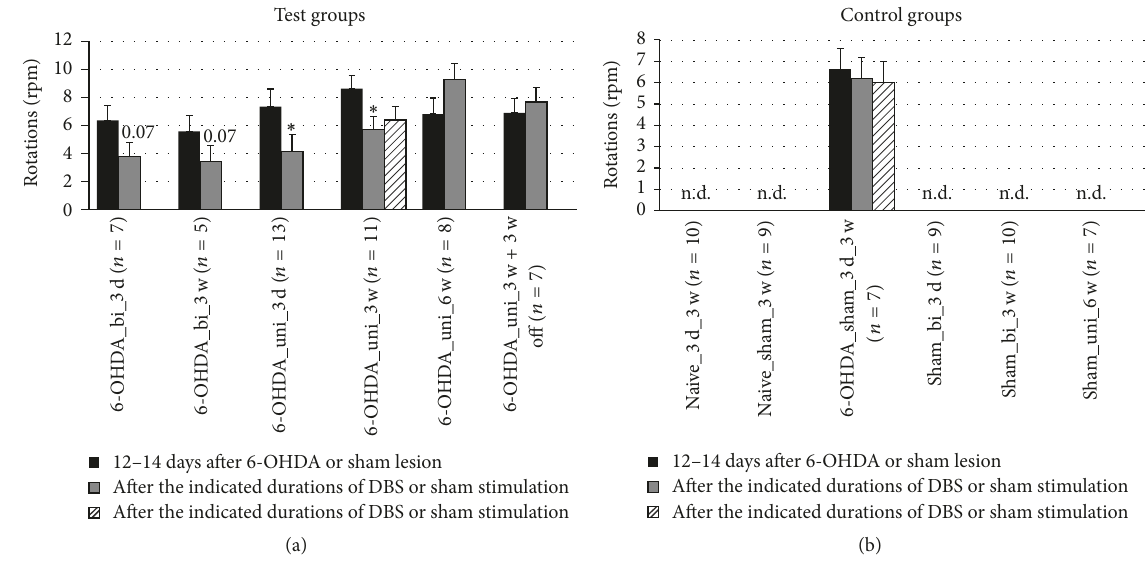
Figure 5: Short-term and long-term effects of DBS with uni- and bipolar electrodes on the apomorphine-induced rotation behavior of hemiparkinsonian rats. (a) and (b) refer to test groups and controls, respectively. Different column patterns indicate the different times of behavioral testing; black: 12–14 days after 6-OHDA or sham lesion; gray and hatched: after the durations of DBS or sham stimulation indicated in the group labels. For experimental details see Table 1. Significance levels are indicated with asterisks as follows: ∗ 𝑝 ≤ 0.05 , b (borderline): 0.05 < 𝑝 ≤ 0.08 according to one-way ANOVA. Asterisks refer to comparisons with corresponding black